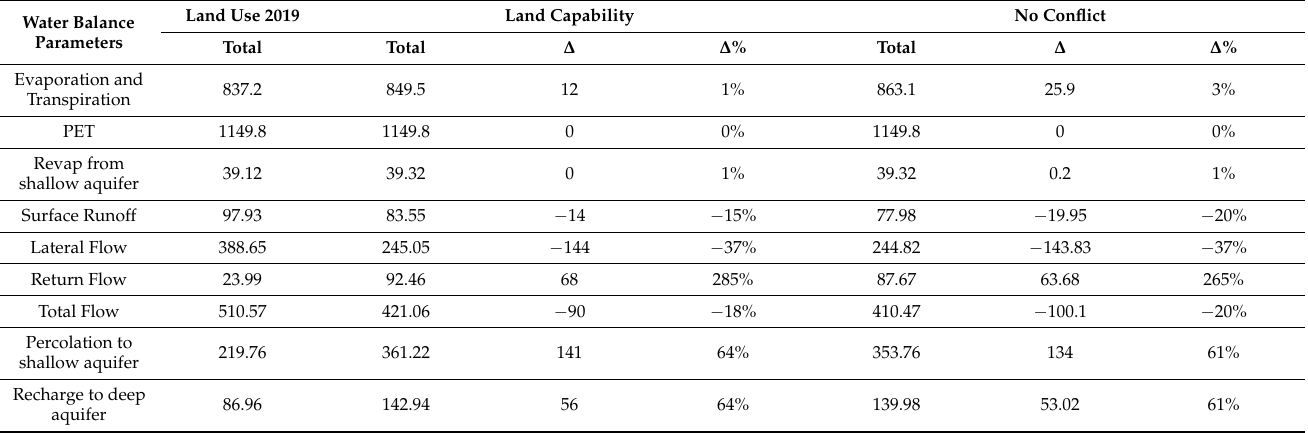
Table 10. Comparison of the Water Balance of the LULCC 2019 with Scenario 3: Land Capability and Scenario 4: No